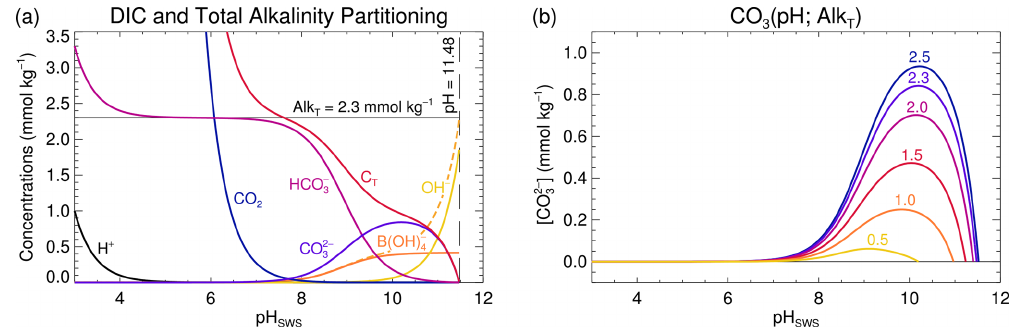
Figure 4. (a) Evolution of the concentrations of the different species composing Alk T – C T , as a function of pH, for Alk T = 2 . 3mmolkg − 1 . C T and the concentrations all of its components reduce to 0 at pH = 11.48 (marked by the long-dashed vertical black line) in this example. The dashed orange line represents the joint contribution of B(OH) − and OH − which are the dominant Alk T contributors at high pH. (b) [ CO 2 − 4 as a function of pH for different Alk T values (indicated in mmolkg − 1 for each curve). Each curve represents a horizontal cross-section at ] distribution depicted in Fig. the corresponding Alk T level through the [ CO 2 − 3